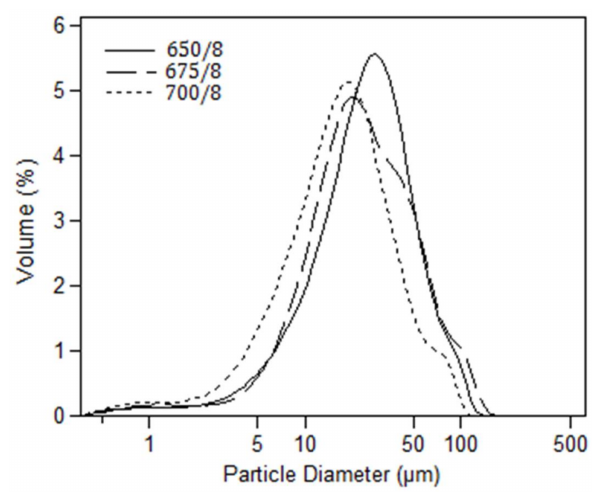
Figure 6. Relative volume distribution of particle sizes for BICUTIVOX platelets synthesized using molten salt at various treatments T(C ◦ )/t(h).